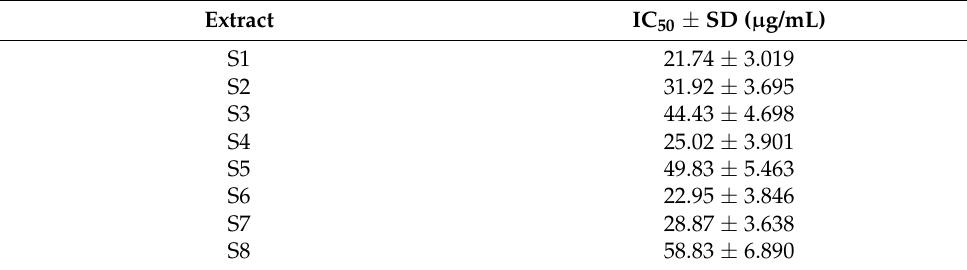
Table 6. Inhibitory activity on the nitrites